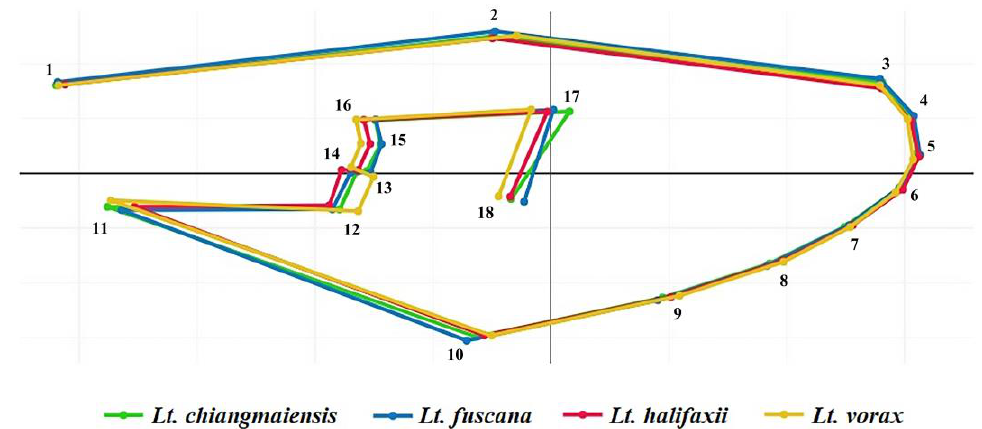
Figure 5. Superimposed wireframe graph showing the superposition of the average wing shape of each Lutzia species, including Lt. chiangmaiensis , Lt. fuscana , Lt. halifaxii , and Lt. vorax .